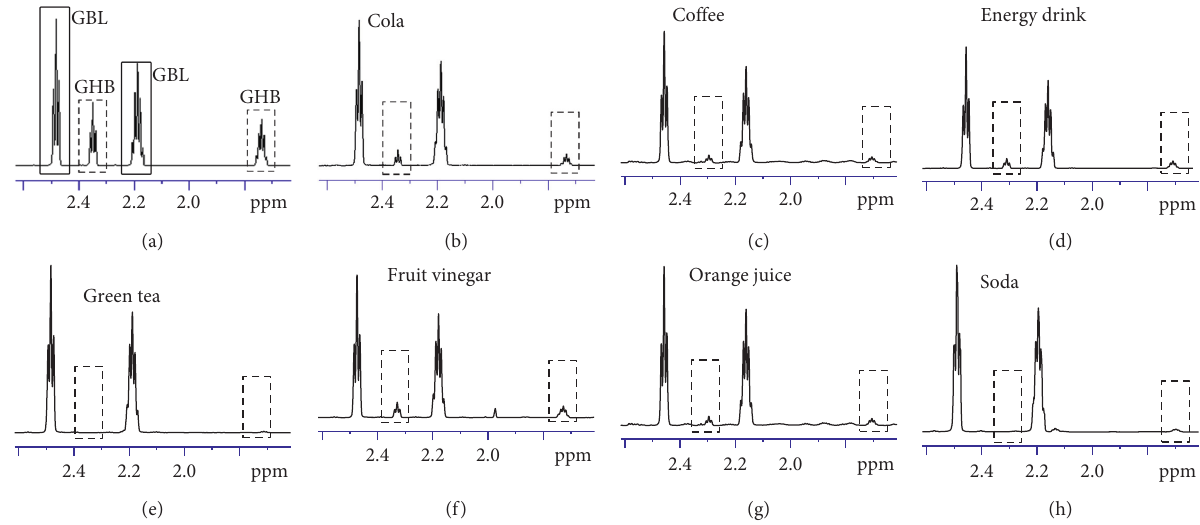
Figure 1: The 1H-NMR results of GBL spiked into simulated acidic solution (a) and other seven popular beverages (b–h). The signals in solid wireframe in (a) were attributed to GBL and signals in dotted wireframe in all figures were attributed to GHB.